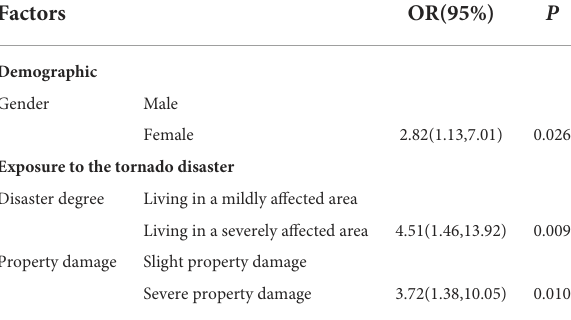
TABLE 4 Results of binary logistic regression on factors associated with PTSD in rural residents who survived the tornado disaster.